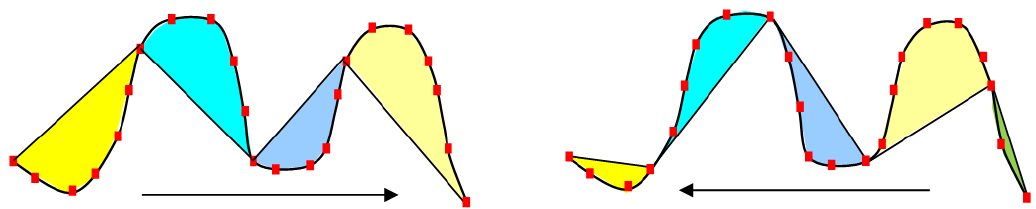
Figure 4. The ODC division starting from different sides ( left / right ).